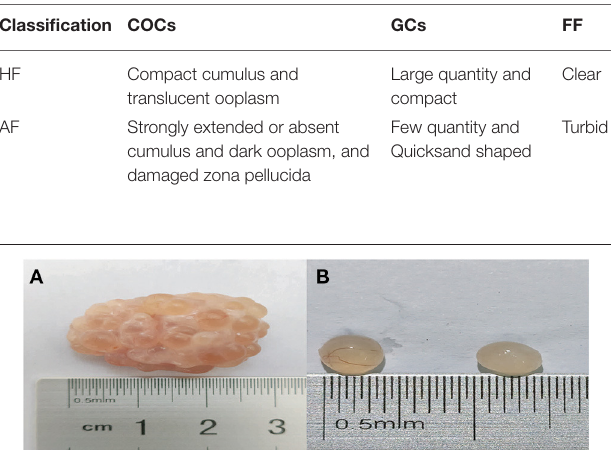
TABLE 3 | Classification of follicles based on the state of COCs and granulosa cells.